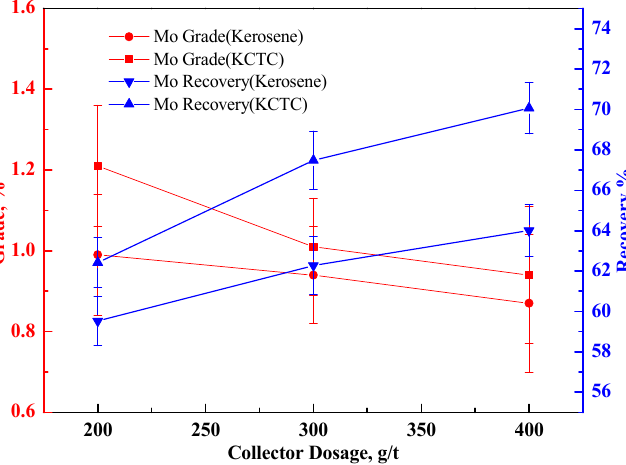
Figure 12. Effects of kerosene and KCTC on the flotation of actual molybdenum ores.